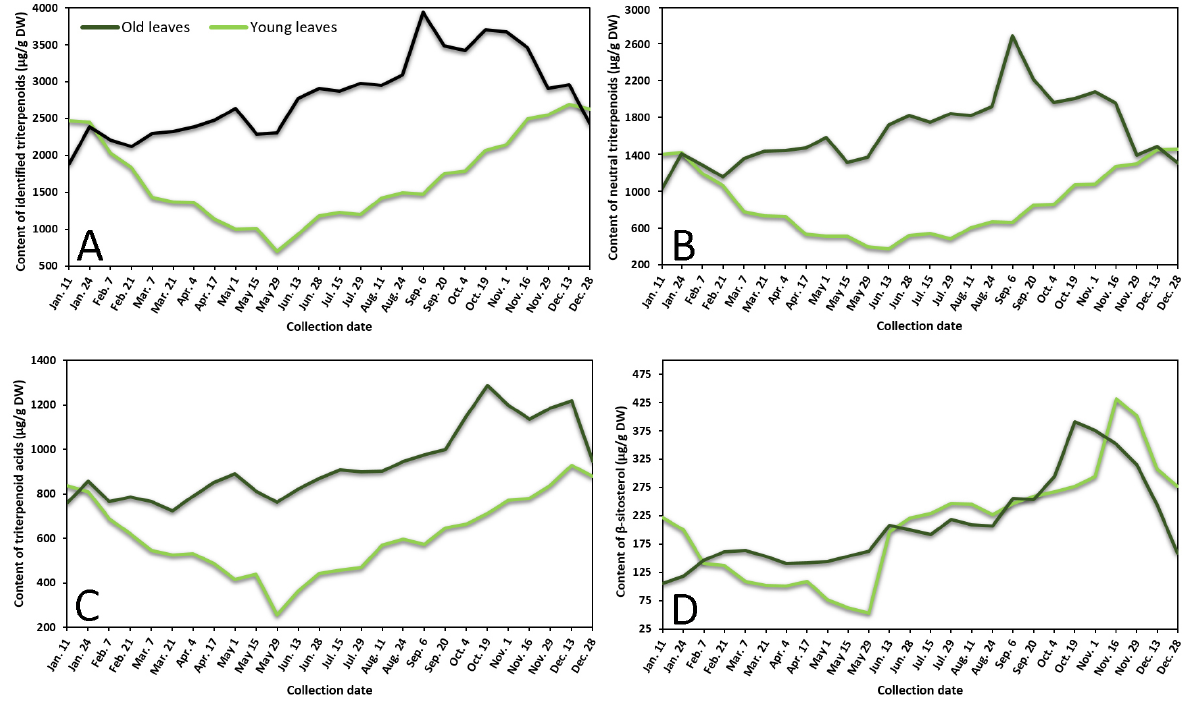
Figure 2. Variation in sums of ( A ) all identified triterpenoids, ( B ) neutral triterpenoids, ( C ) triterpenoid acids, and ( D ) β - sitosterol ( µ g/g DW) in young (light line) and old (dark line) lingonberry leaves during one year testing period.